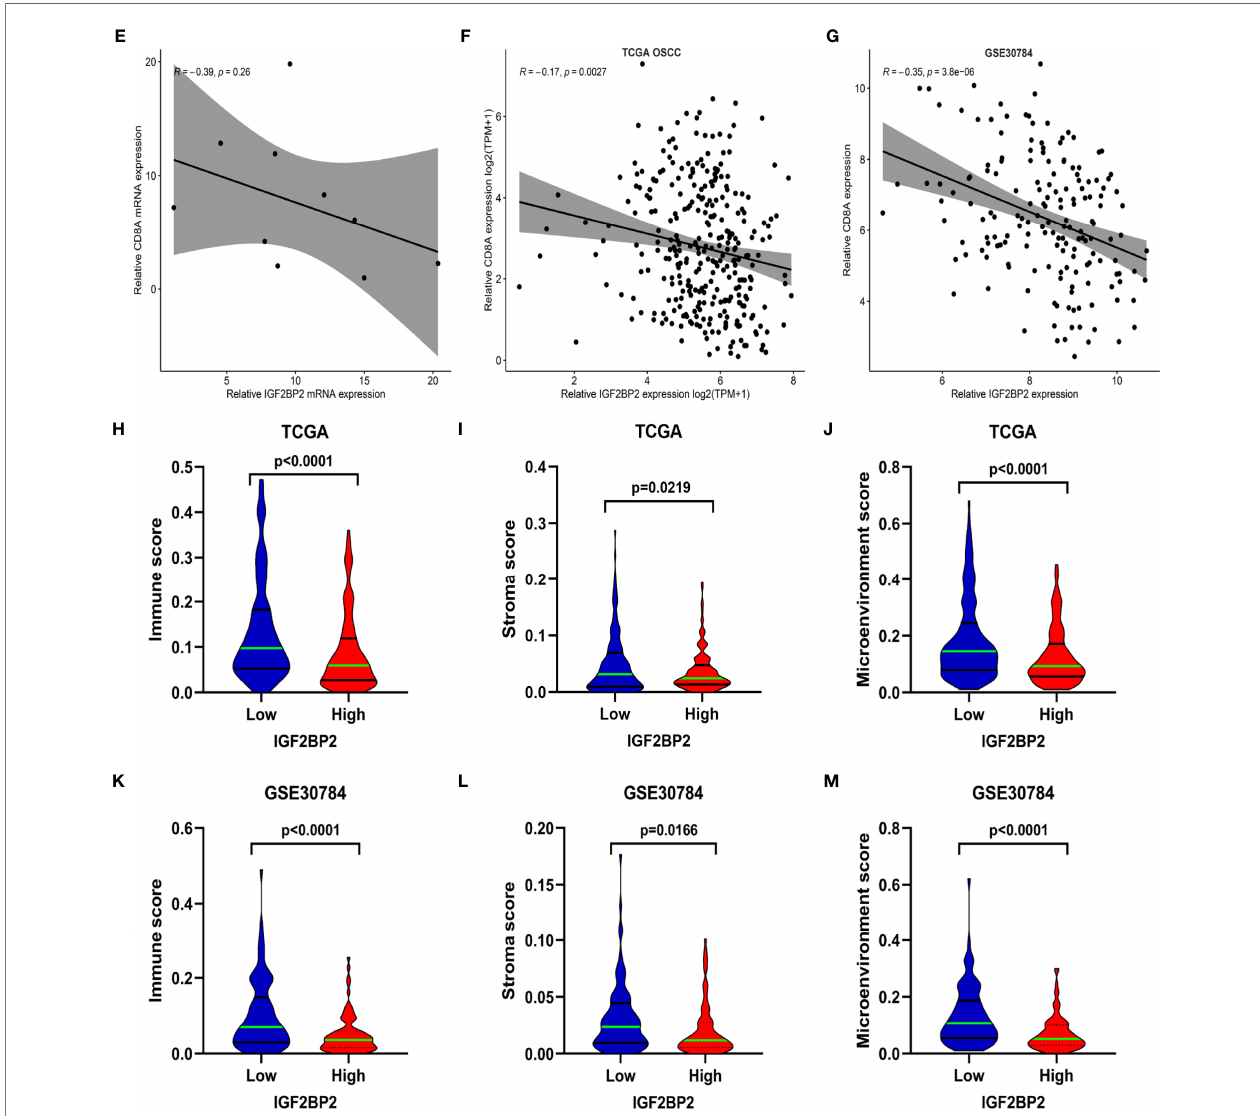
FIGURE 5 | Correlation between immune in fi ltrates and IGF2BP2 expression in OSCC. (A, B) In fi ltration fraction between IGF2BP2 expression and 22 immune cells in the OSCC in TCGA-OSCC (A) and GSE30784 datasets (B) according to the CIBERSORT algorism. (C, D) Boxplots show IGF2BP2 expression and the score of 28 immune cells in the OSCC in TCGA-OSCC (C) and the GSE30784 datasets (D) with ssGSEA algorism. (E) Correlation between IGF2BP2 and CD8A expression in TCGA-OSCC dataset. (F) Correlation between IGF2BP2 and CD8A expression in GSE30784 dataset. (G) Correlation between the mRNA levels of IGF2BP2 and CD8A in 10 OSCC tissues. (H – J) The immune score (H) , stromal score (I) , and microenvironment score (J) of the IGF2BP2 high- and low-expression groups in the OSCC in the TCGA database according to the xCell algorithm. (K – M) The immune score (K) , stromal score (L) , and microenvironment score (M) of IGF2BP2 high- and low-expression groups in the OSCC in the GSE30784 dataset according to the xCell